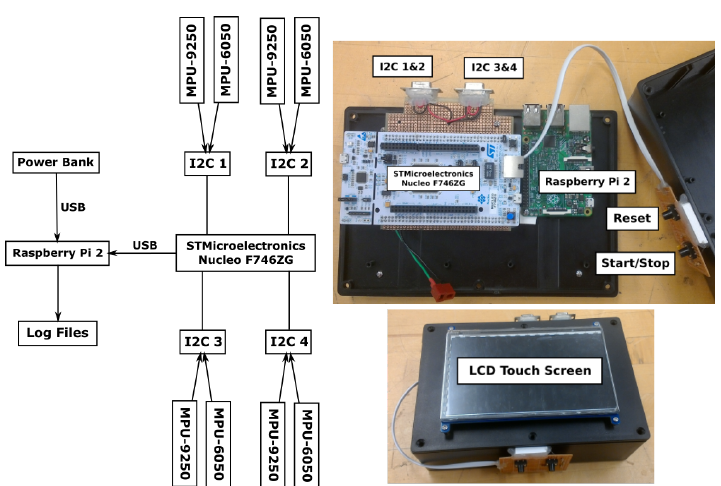
Figure 2. Sensor data logger system flowchart and its components.